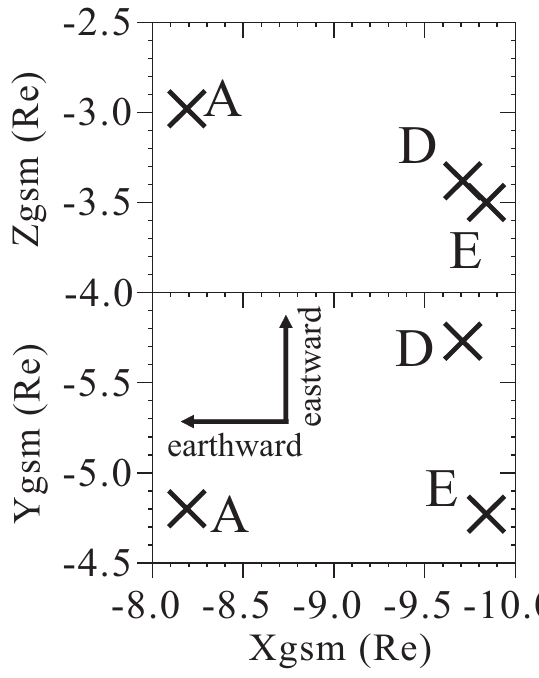
Fig. 3. Locations of the THEMIS A ( − 8.2, − 4.8, − 3.0), D ( − 9.7, − 5.7, − 3.4), and E ( − 9.8, − 4.8, − 3.5) satellites in the GSM coor- dinates at 08:10UT on 10 January 2008.